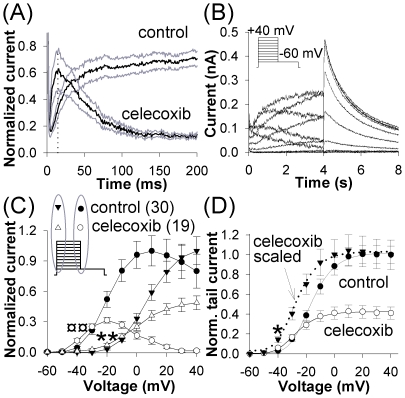
Modification of hERG gating by celecoxib.(A) Expanded first 200 ms from Fig. 2A
 shows a transient increase in hERG amplitude in the presence of celecoxib at 15 ms (vertical line) after the onset of pulse; gray traces indicate the range of SE. (B) Examples of hERG in control elicited by 4 s pulses to −60 mV after 4 s pre-pulses to voltages between −60 and +40 mV in 10 mV increments. (C) Normalized voltage-current relations for the sustained (end of a 4 s pre-pulse) and transient (maximal amplitude during the first 20 ms of pulse) components of hERG in control and at 10 µM celecoxib; currency signs mark statistical significance for circles, asterisks – for triangles. (D) Voltage-dependence of peak tail currents plotted against the pre-pulse voltage in control and at 10 µM celecoxib.